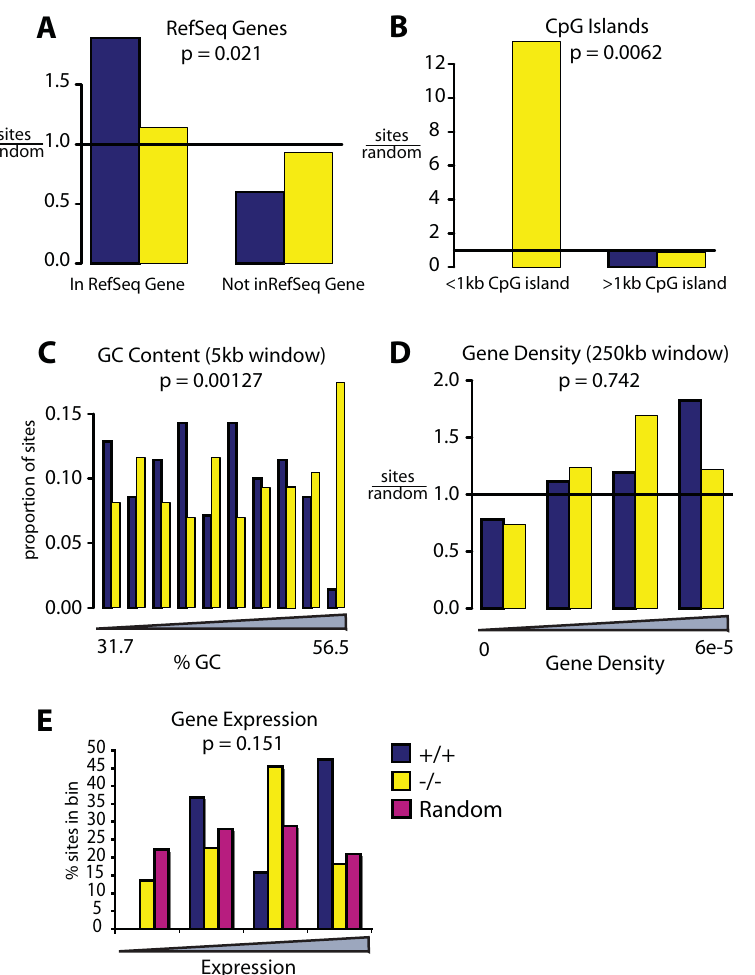
Figure 7. EIAV integration distributions in murine control and LEDGF/p75-disrupted cells. Integration frequencies are shown relative to A) RefSeq genes, B) CpG islands (1 kb window; note that there were no control sites within , 1 kb), C) G/C content, D) Gene density (250 kb window), E) Gene activity. Markings as in Figure 4.